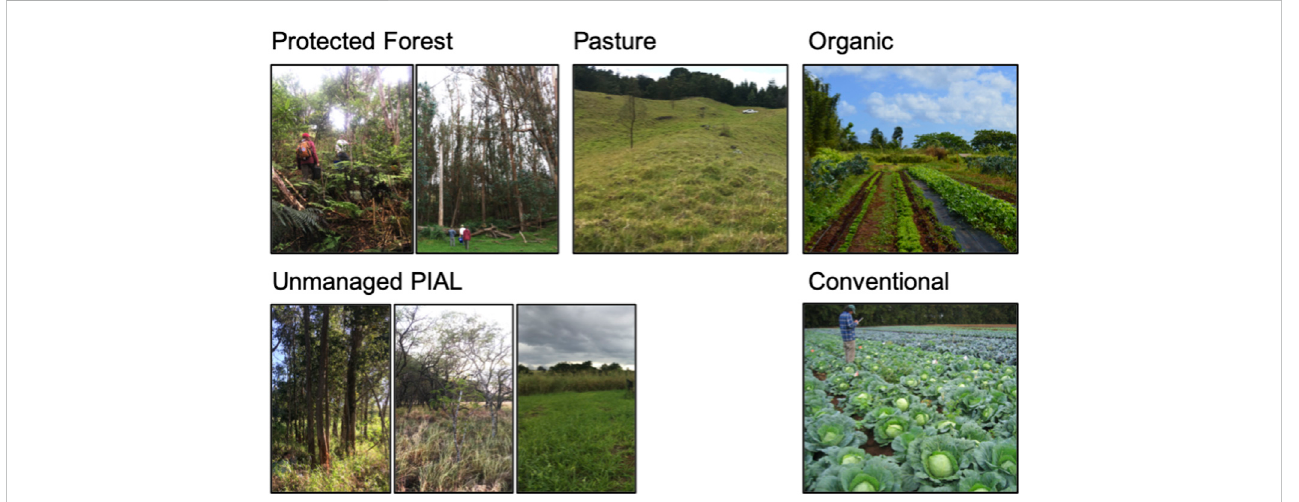
FIGURE 1 Images from fi eld sites in each category of current land use. Protected forest included both native (left) and non-native (right) stands. Unmanaged, previous intensive agriculture lands (PIAL) included forest stands (left), shrub lands (center), and grasslands (right). Pasture sites were managed grazing lands; croplands included organic and conventional